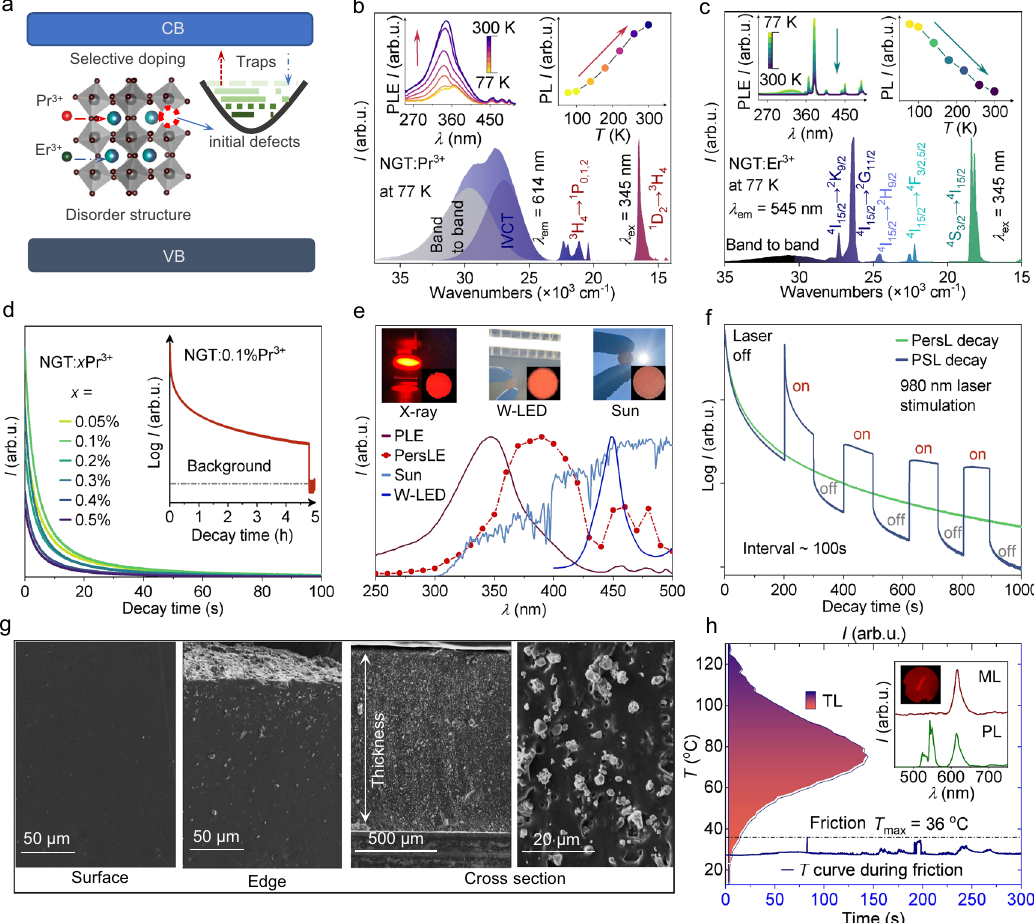
Fig. 1 | Multimode luminescence of Pr 3+ and/or Er 3+ -doped NGT phosphors. a Sequential process leading to multimode luminescence via selective doping Pr 3+ and Er 3+ ions into the disordered NGT. CB, conduction band; VB, valence band. b Photoluminescence (PL) and PL excitation (PLE) spectra of NGT:0.1%Pr 3+ at 77K. The excitationspectrum is fi tted by Gaussianfunctions. Insets arethe temperature dependent PLE spectra and PL intensities. I , intensity; arb. u., arbitrary units; λ , wavelength; T , temperature; ex, excitation; em, emission. c PLE and PL spectra of NGT:2%Er 3+ at 77K. Insets show the temperature dependent PLE spectra and PL intensities. d Persistent luminescence (PersL) decay curves of NGT: x Pr 3+ ( x =0.05% – 0.5%) monitored at 614nm after 365nm excitation for 1min. Inset shows the PersL decay curve of NGT:0.1%Pr 3+ recorded for 5h. e Comparison of solar spectrum, white light emitting diode (W-LED, bule chip+Y 3 Al 5 O 12 :Ce 3+ ) spectrum, excitation spectrum of PersL (PersLE), and PLE of NGT:0.1%Pr 3+ at room